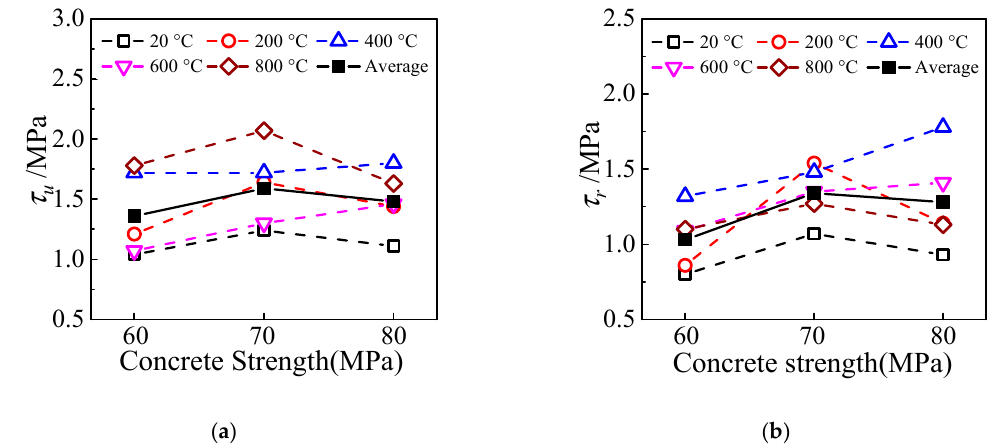
Figure 16. The effect of concrete strength on bond strength ( a ) ultimate bond strength; ( b ) residual bond strength.